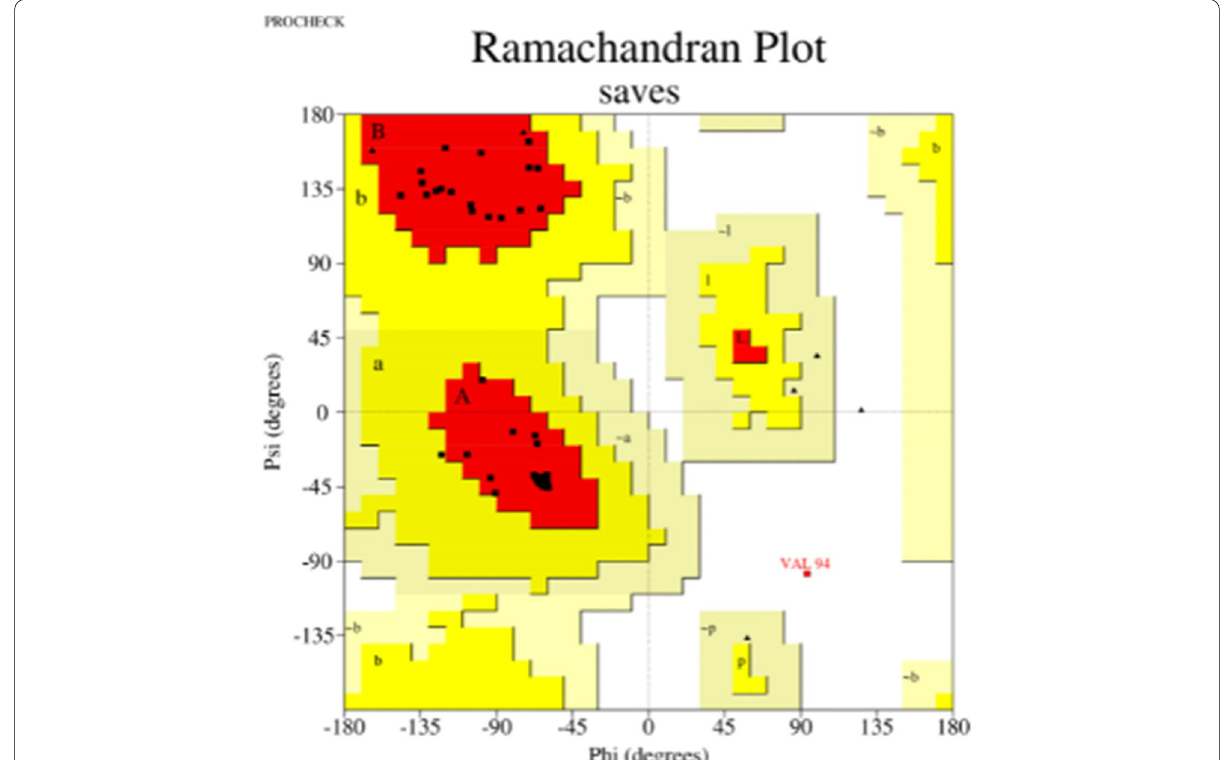
Fig. 4 Validation of tertiary structure by Ramachandran plot analysis in PROCHECK server